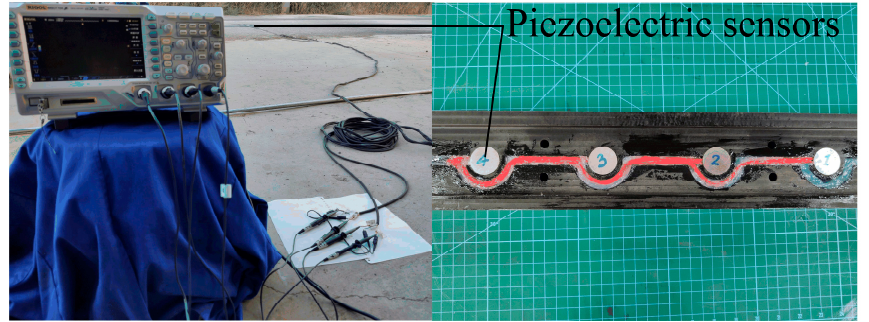
Figure 8. Road dynamic weighing system.